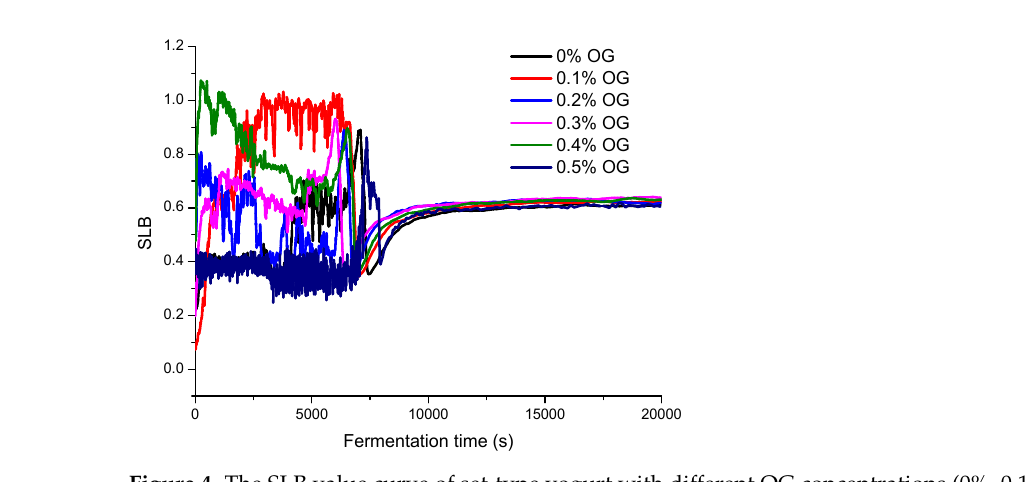
Figure 3. The EI value curve of set-type yogurt with different OG concentrations (0%, 0.1%, 0.2%, 0.3%, 0.4%, and 0.5%) during fermentation.